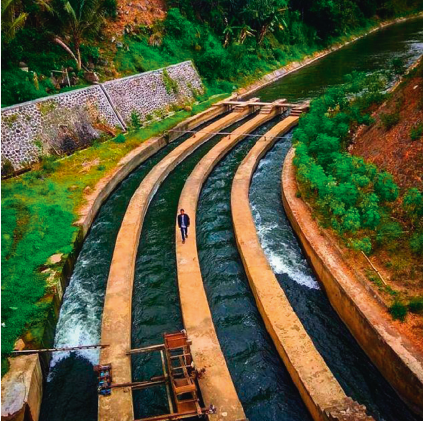
Figure 7: Irrigation canal in Bligo village, Ngluwar district, Magelang regency, Central Java province, Indonesia.